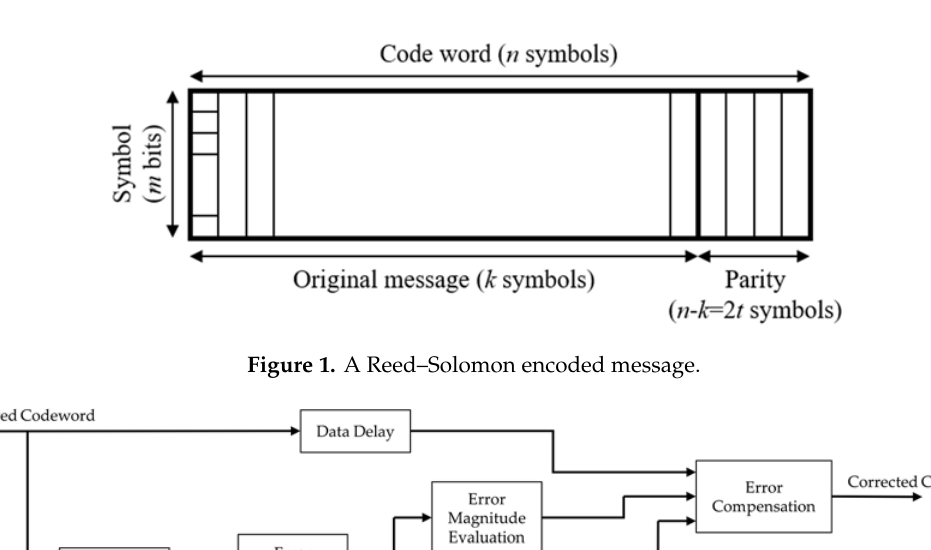
Figure 3. Error magnitude evaluation block.